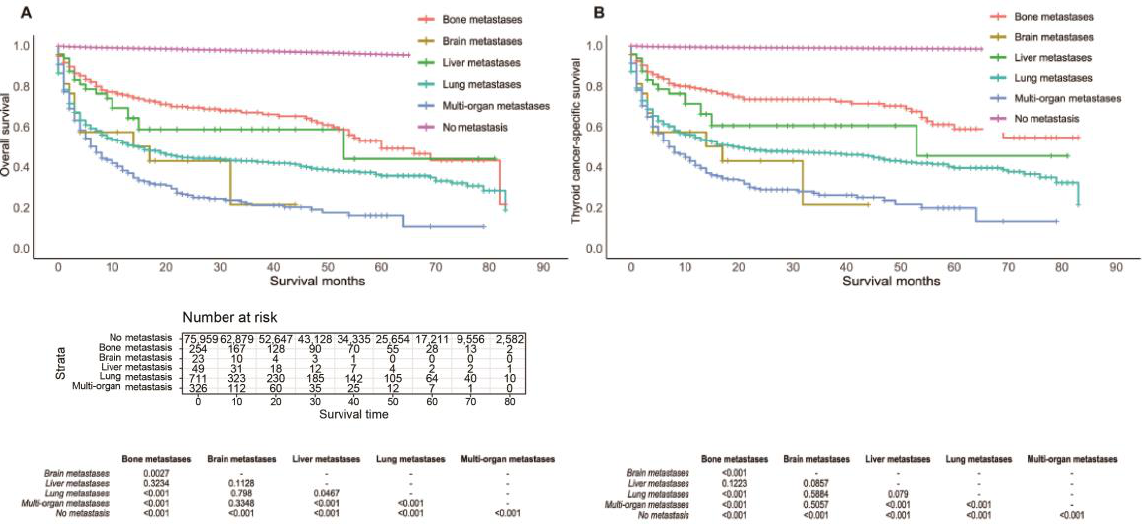
Figure 2. Kaplan–Meier curve of overall survival ( A ) and thyroid cancer-specific survival ( B ) accord- ing to the site of metastasis.